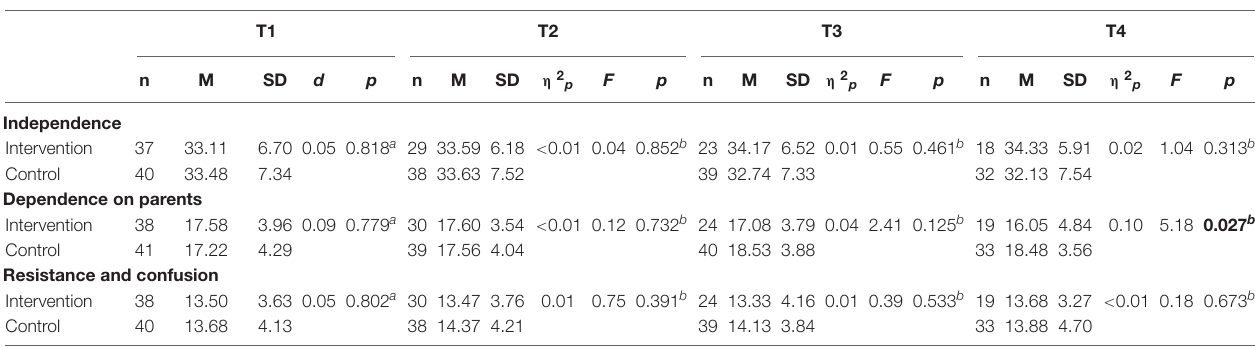
TABLE 4 | Differences in independence consciousness between groups as measured by the Independent Consciousness Scale. T1 T2 T3 T4 n M SD d p n M SD η 2